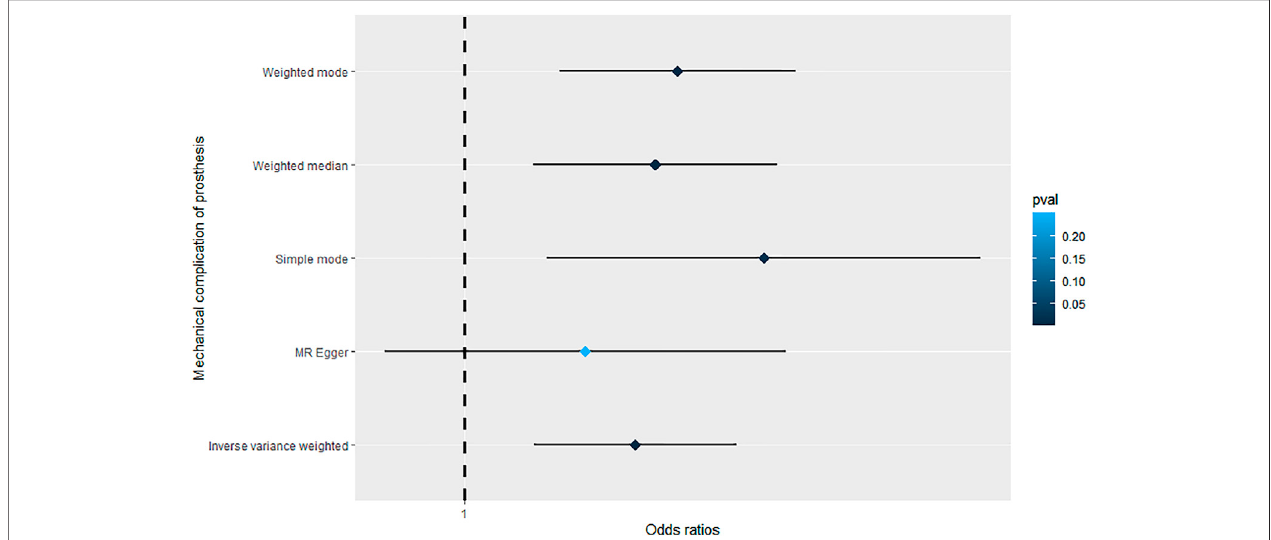
FIGURE 2 | Forrest plot of the causal effects of RA-associated SNPs on mechanical complications of prosthesis.